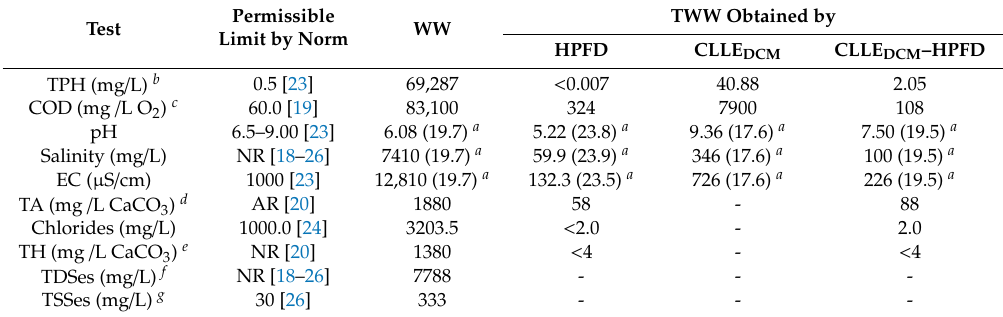
Table 3. Physicochemical properties of the nondomestic wastewater (WW) and the treated wastewater (TWW) obtained through CLLE DCM , HPFD, or CLLE DCM -HPFD for samples of WW from the sedimentation pond of a petroleum production